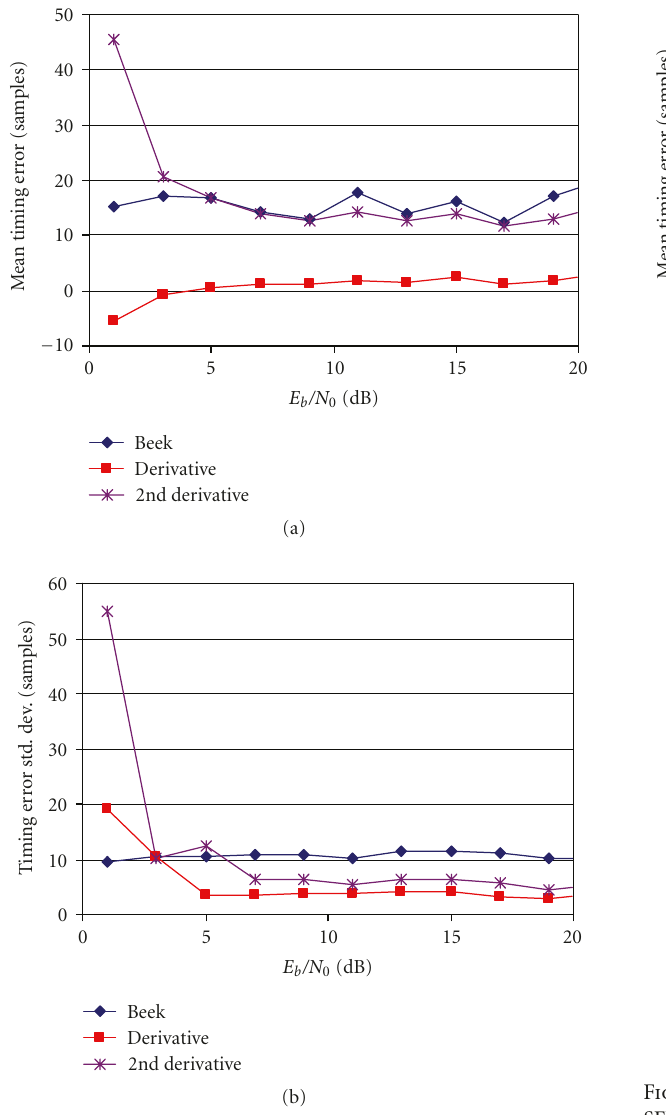
Figure 4: Timing-error performance comparison as a function of E b /N 0 .